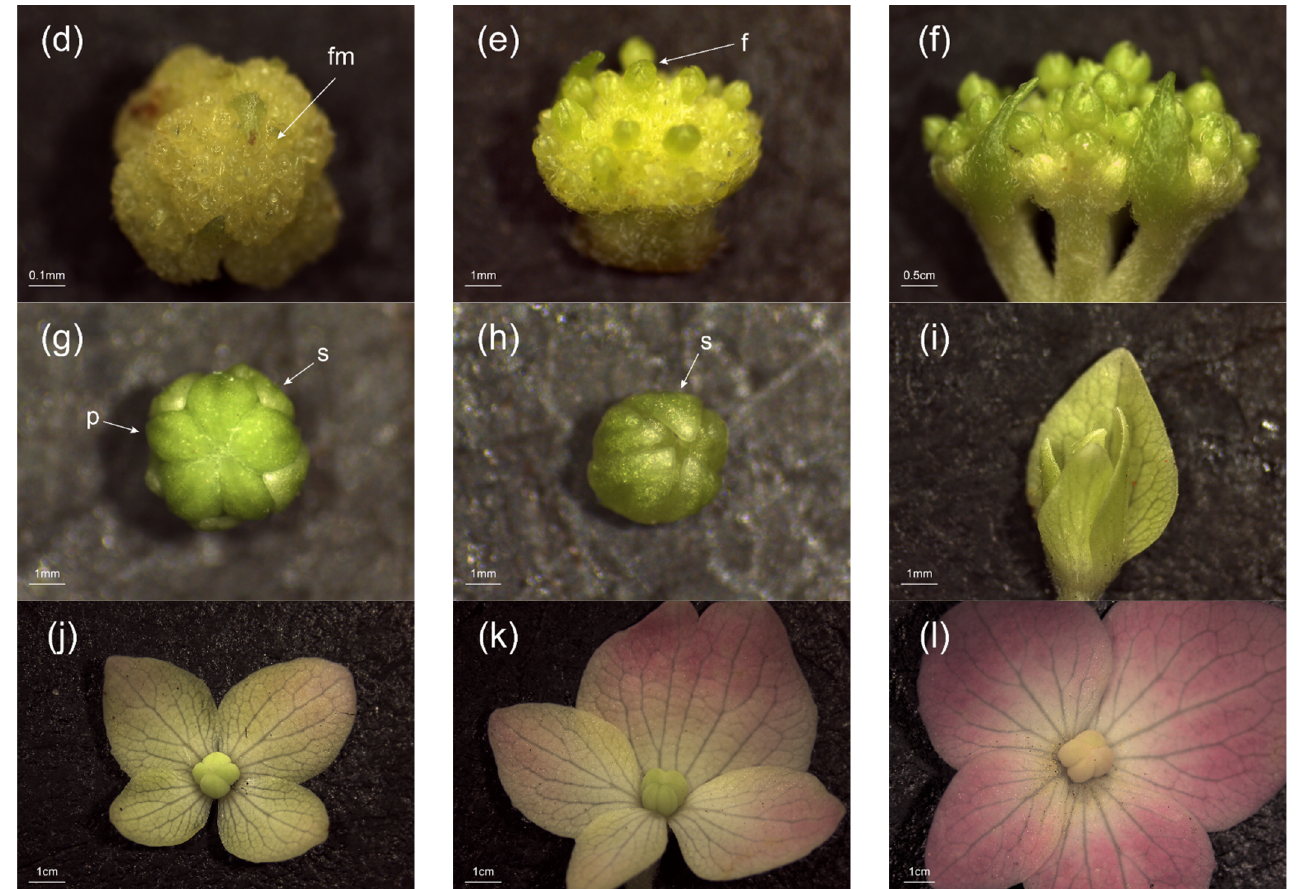
Figure 1. Flower development stages of Hydrangea macrophylla ‘Endless Summer’ observed by stereomicroscope. ( a ) Vegetative bud. ( b ) Inflorescence meristem dome formation begins. ( c ) Spherical shape formed by numerous inflorescence meristem domes. ( d ) Floral primordium differentiation stage. ( e ) Floral organ differentiation stage. ( f ) Secondary branching of spherical inflorescence. ( g ) Nondecorative floret on secondary inflorescence branching. ( h ) Decorative floret on secondary inflorescence branching. ( i ) Decorative floret with elongated sepals. ( j ) Decorative floret sepals unfold. ( k ) Decorative floret sepals start to turn color. ( l ) Decorative floret sepals completely changed color. vm = vegetative meristem; im = inflorescence meristem; fm = floral meristem; fp = foliar primordia; f = floret; s = sepal; p = petal.